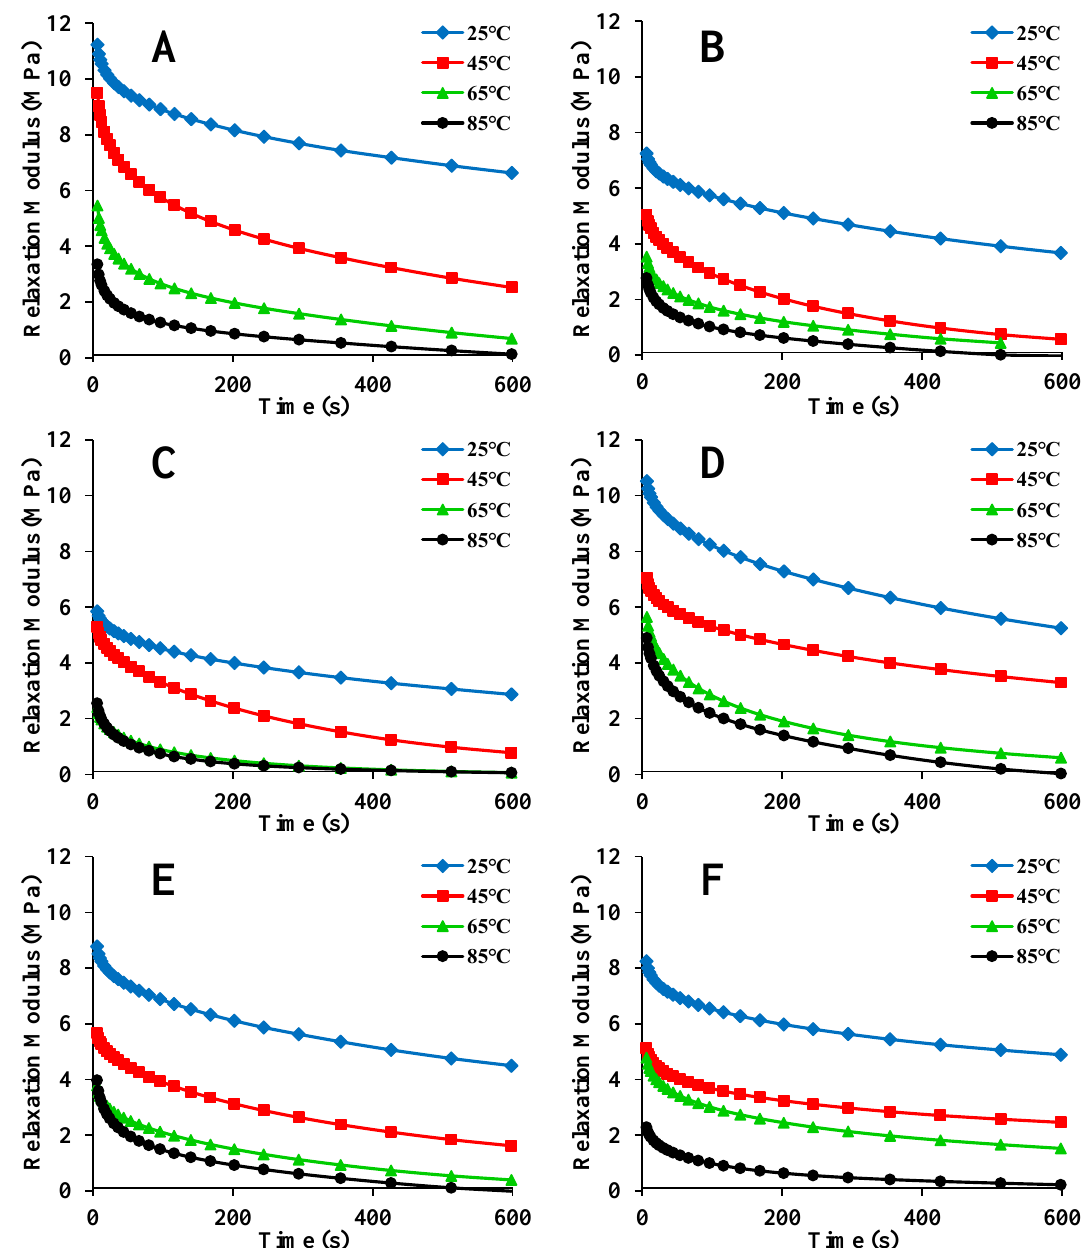
Figure 1. Relaxation modulus data for maize kernels at different temperatures: ( A ) natural drying (ND); ( B ) hot air/vacuum drying (HVD) 35 ◦ C; ( C ) HVD 45 ◦ C; ( D ) HVD 55 ◦ C; ( E ) HVD 65 ◦ C; ( F ) HVD 75 ◦